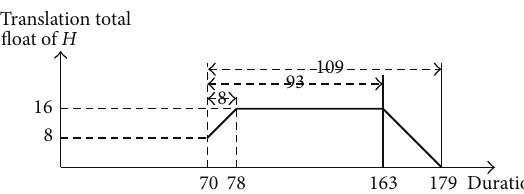
Figure 8: Curve chart of translation total float of the activity 𝐻